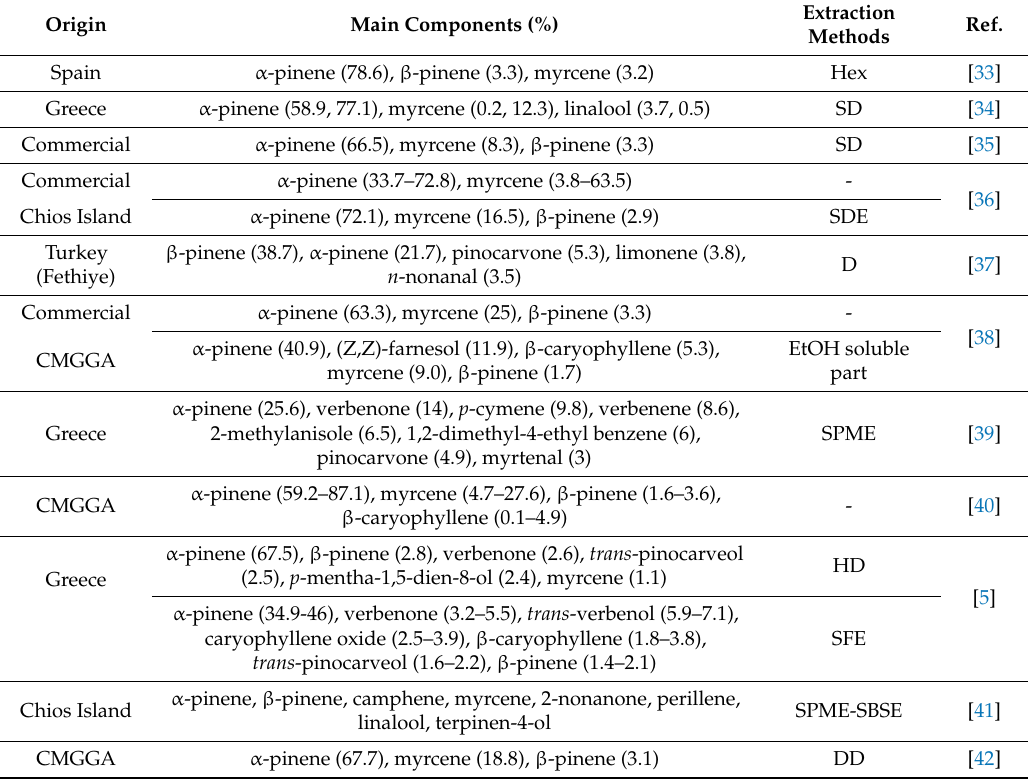
Table 2. Essential oils from the gum of P. lentiscus var. chia collected from di ff erent geographic locations, main components, and extraction methods based on the literature survey from 1990 to 2020